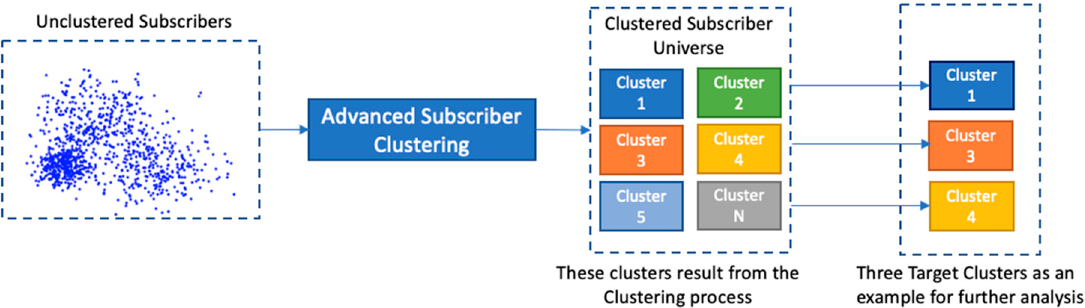
Figure 1. Subscriber-centric clustering process.